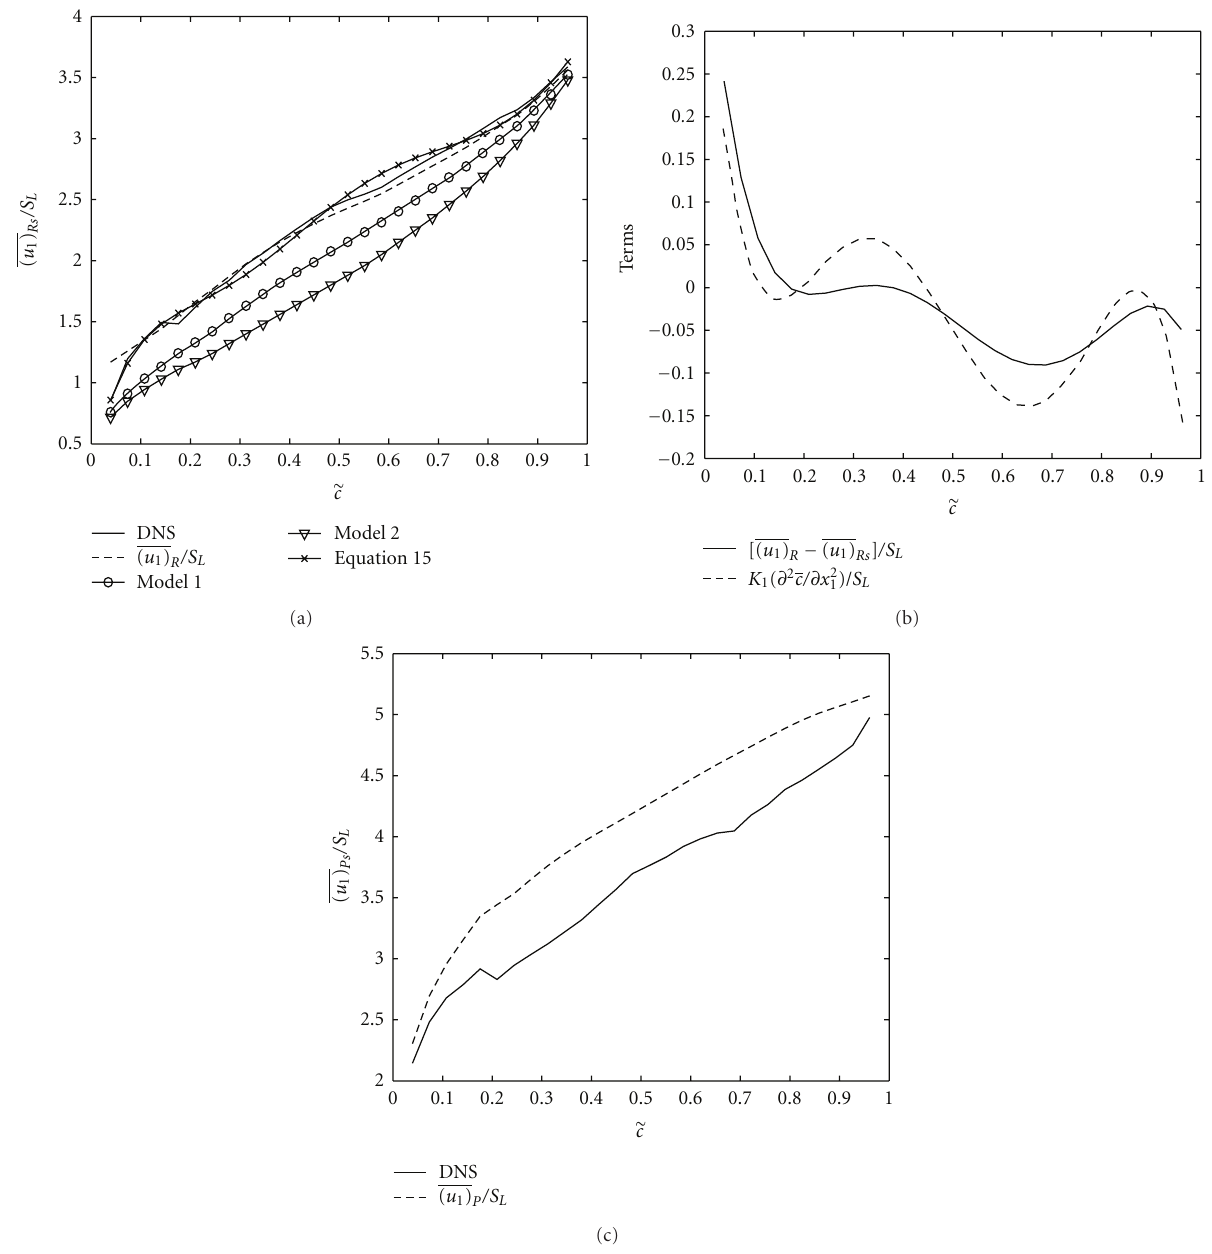
Figure 5: (a) Variations of ( u 1 ) and ( u 1 ) with (cid:2) c across the flame brush along with the predictions of (11c) according to (cid:9) c (cid:10) = c Rs /S L R /S L (shown as Model 1 in the legend) and (cid:9) c (cid:10) = (cid:2) c (shown as Model 2 in the legend) and (15). (b) Variations of [( u 1 ) K 1 ( ∂ 2 c/∂x 1 ) /S L = 2 C μ ( (cid:2) k 2 / (cid:2) ε ) R ( ∂ 2 c/∂x 2 1 ) / [( ∂c/∂x 1 ) S L ] with (cid:2) c . (c) Variations of ( u 1 ) Ps /S L and ( u 1 ) P /S L with (cid:2) c across the flame brush.